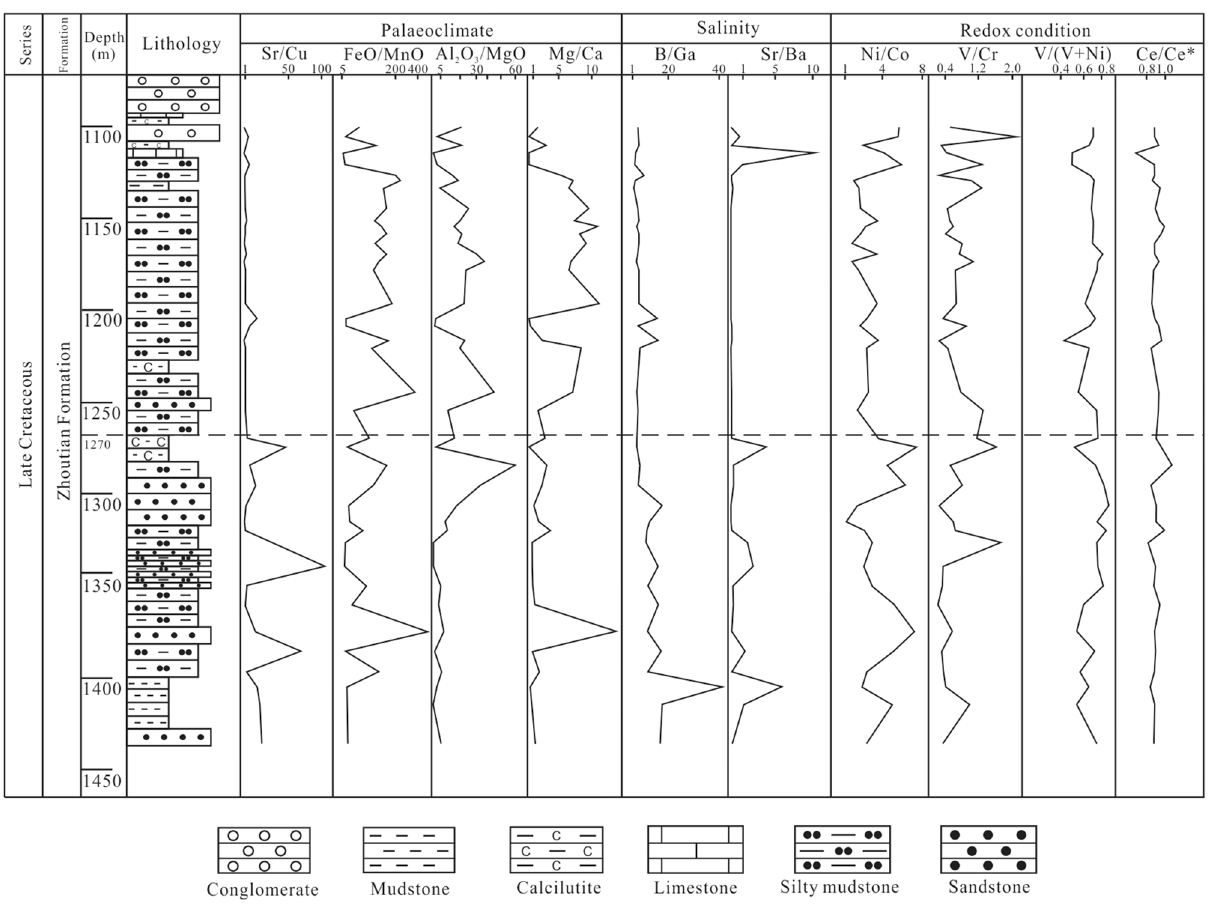
Figure 5. Element ratios from the lower Zhoutian Formation in the Jitai Basin as palaeoclimate, salinity and redox-condition proxies.